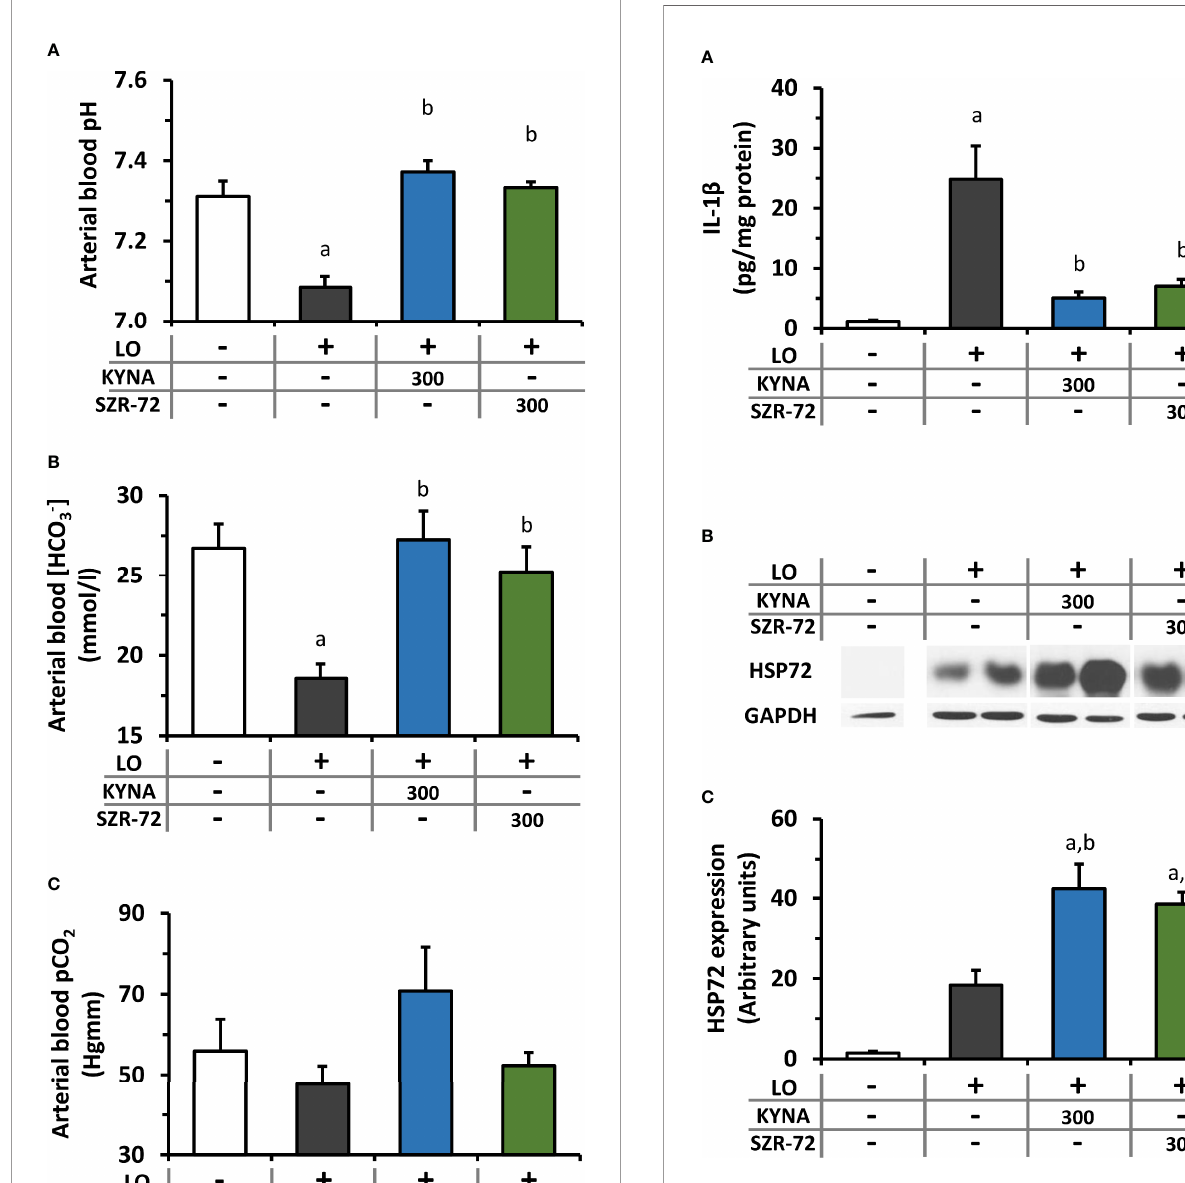
FIGURE 6 | Changes in interleukin 1 beta (IL-1 b ) and heat shock protein 72 (HSP72) levels in AP in rats treated with 300 mg/kg KYNA or SZR-72. (A) Pancreatic IL-1 b level, (B) representative Western blot images of pancreatic HSP72 and glicerinaldehide-3-phosphate-dehydrogenase (GAPDH) levels, and (C) densitometry of Western Blot images for pancreatic HSP72 level. Values represent means with standard error, n=7-10. One-way ANOVA was performed followed by Holm-Sidak post-hoc test. Statistically signi fi cant differences (p<0.05) were marked with: (a) vs . control; (b) vs .